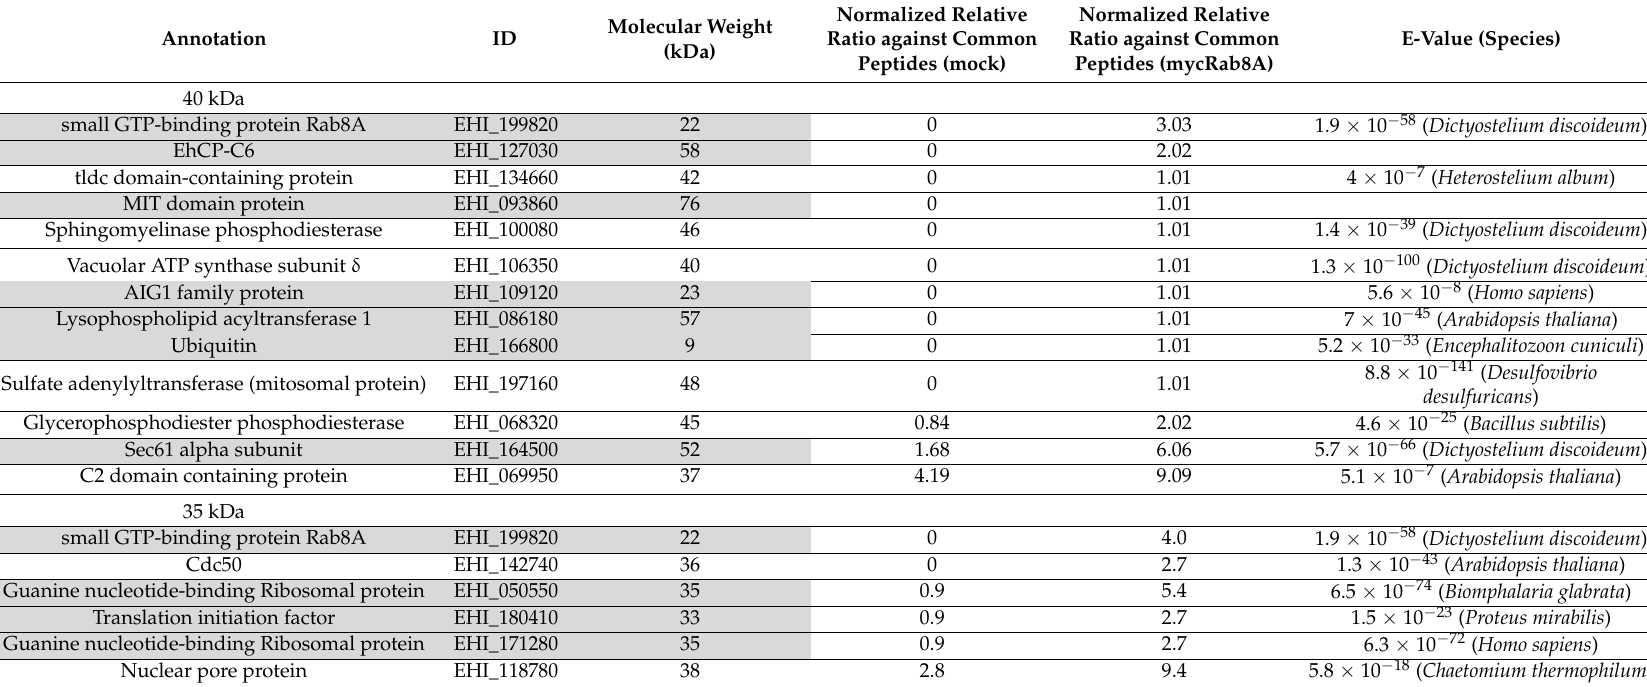
Table A1. Proteins coimmunoprecipitated with